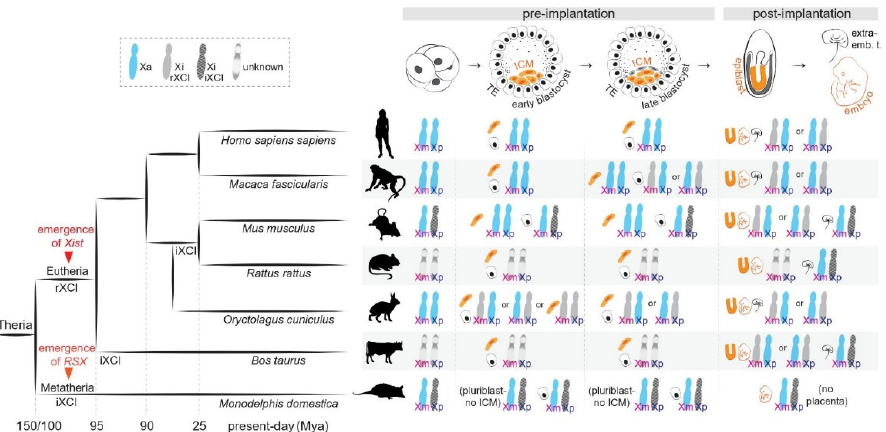
Figure 1. X-chromosome inactivation across species. ( Left ): Phylogenetic tree indicating the evolution of random and imprinted XCI and the emergence of long non-coding RNAs Xist and RSX in Theria. ( Right ): X-chromosome inactivation dynamics across development in representative species.